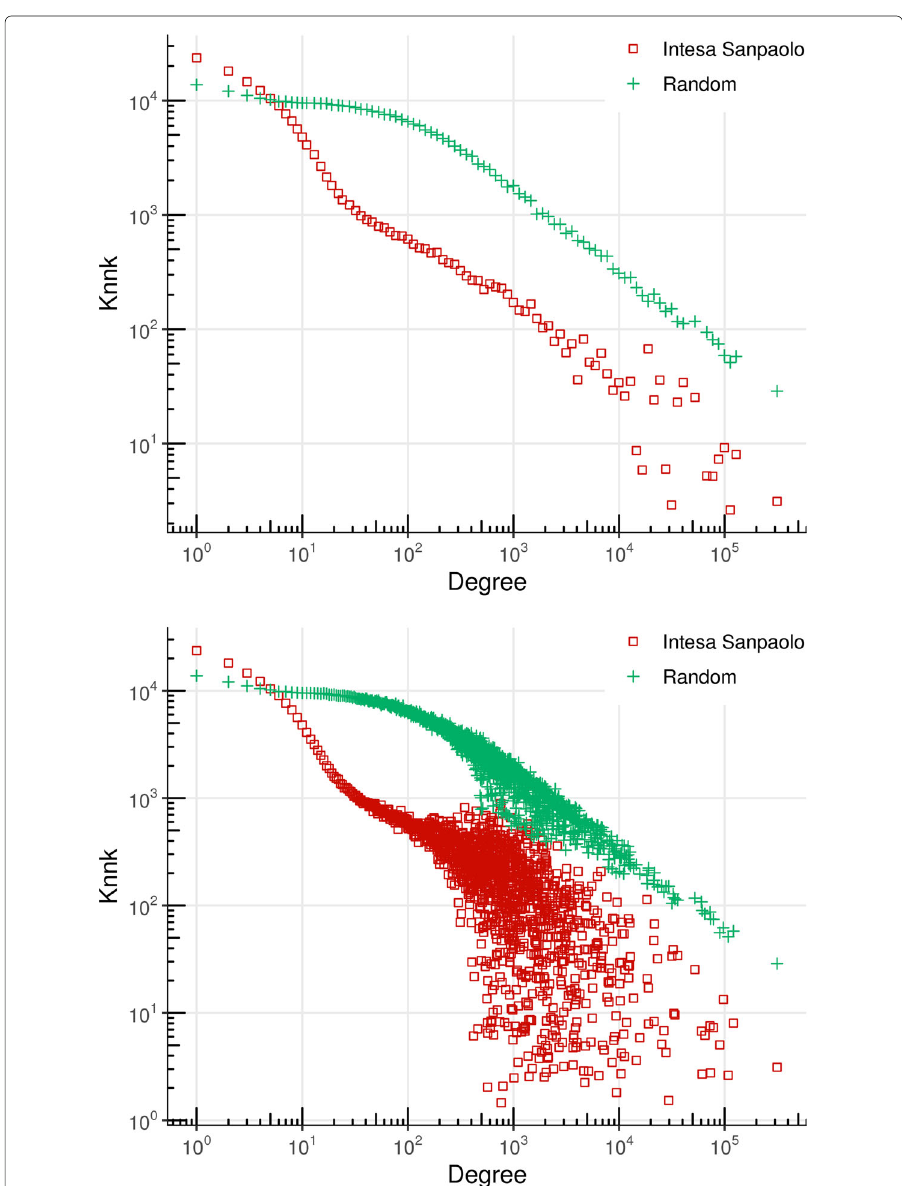
Fig. 8 k nn ( k ) for the wire transfer network (red squares) and its randomised version (green crosses), on a log-log scale with (top) and without logarithmic binning (bottom). In the ISP network, low degree nodes, tend to connect with neighbours with an average high degree, and the other way around. The random network shows a signal to “structural disassortativity”, but the tendency in the ISP is much stronger. Plus, in the ISP’s network, there is a clear inflection right over nodes with a degree of a few tens, where nodes are progressively more likely to be legal entities